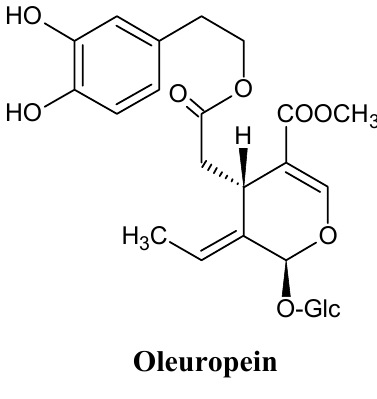
Figure 1. Structures of oleuropein and echinacoside.